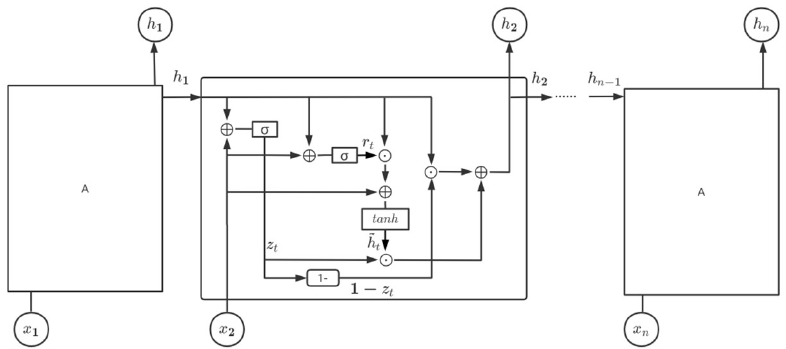
Figure 5. Structure of GRU.